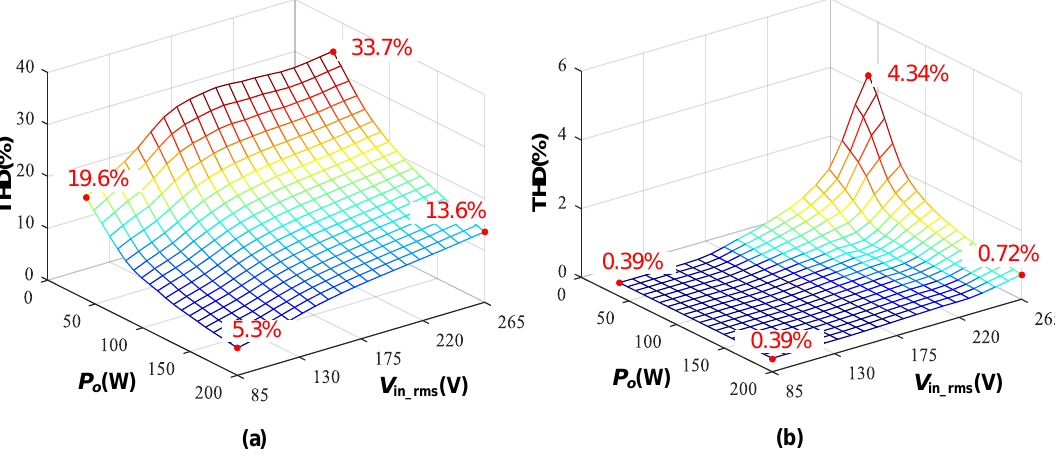
Figure 9. The close-loop THD mappings: ( a ) the COT control; ( b ) the ACVOT control.